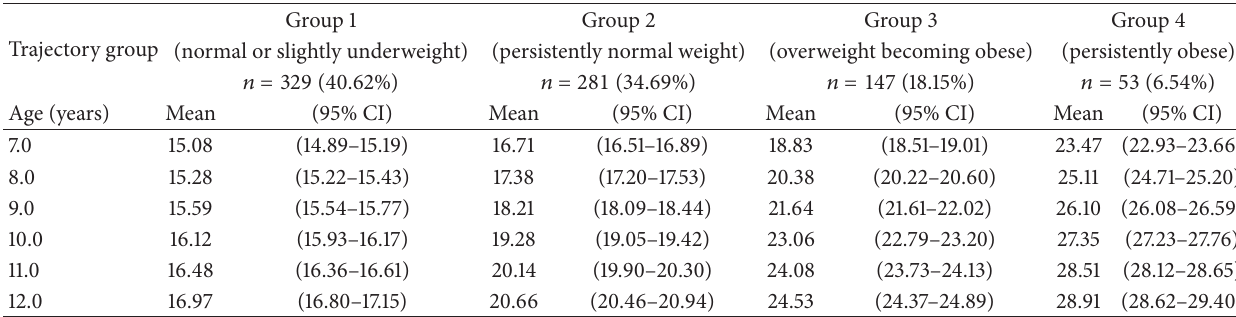
Table 2: Mean BMI by BMI trajectory group and age in